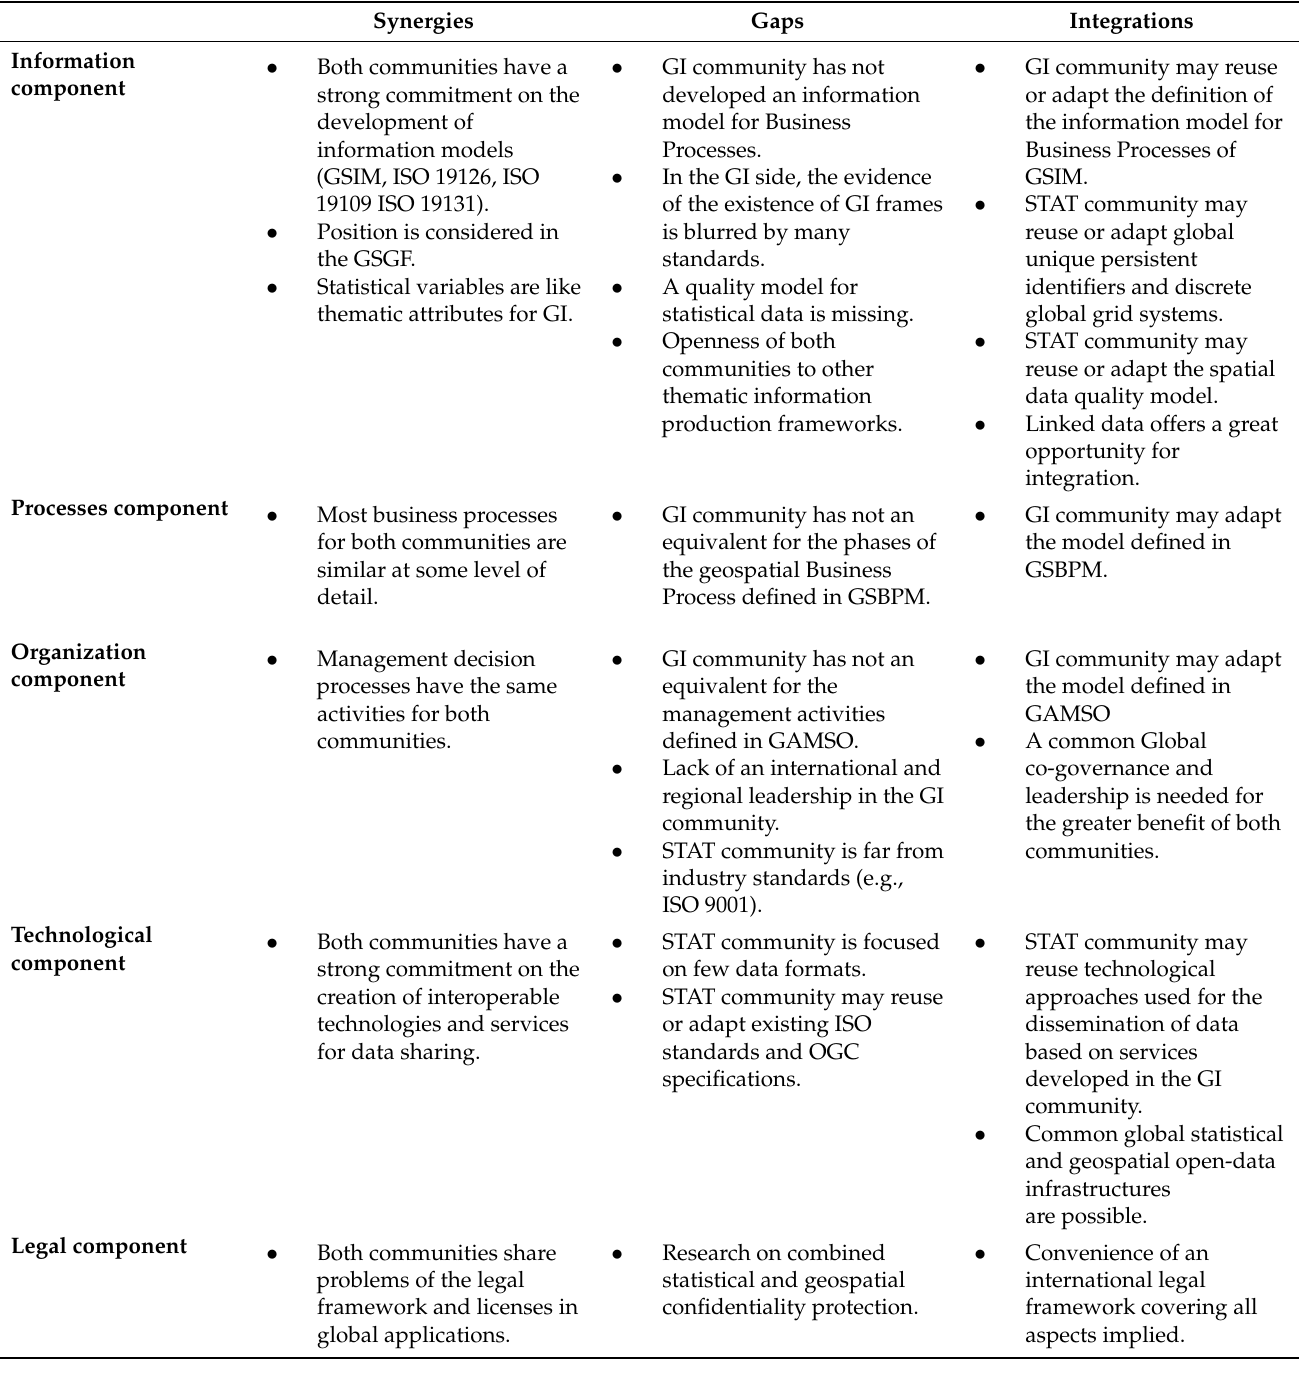
Table 4. Synergies, Gaps and Integration opportunities (Statistical and Geospatial).